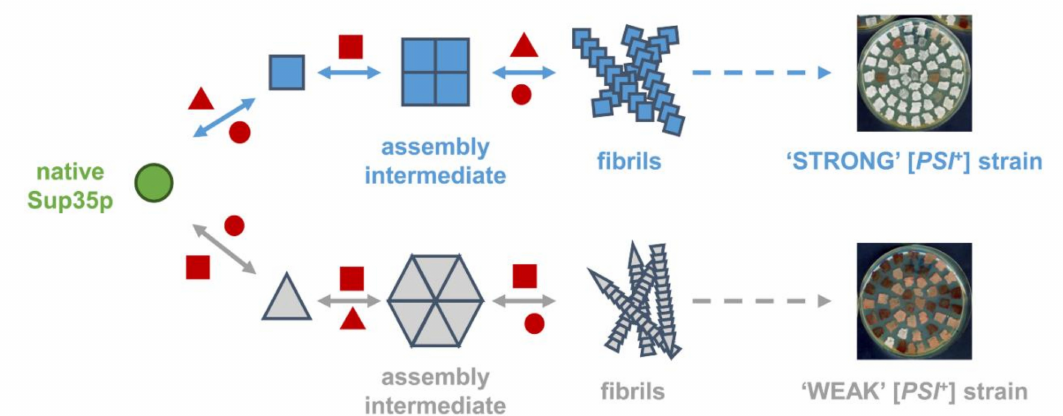
Figure 1. Sup35p assembles into structurally distinct fibrils leading to phenotypically distinct [ PSI + ] strains. Native Sup35p (green circle) can switch to alternate conformations (blue rectangle, grey triangle) that follow different assembly pathways to form structurally distinct fibrillar assemblies. The equilibrium between soluble monomers, oligomers and larger aggregated and fibrillar species is governed by protein folding and protein quality control systems (red squares, triangles and circles), comprising, for instance, molecular chaperones, the 26S proteasome or members of the endosomal–autophagic pathway. Structurally diverse Sup35p assemblies drive the formation of phenotypically distinct [ PSI + ] strains. These are scored on adenine-limiting plates using a genetic tool based upon the extent of nonsense suppression of the ade1–14 allele: [ PSI + ] colonies appear white or pink and are prototrophic for adenine, whereas [ psi - ] prion-free cells form red colonies and are auxotrophic for adenine